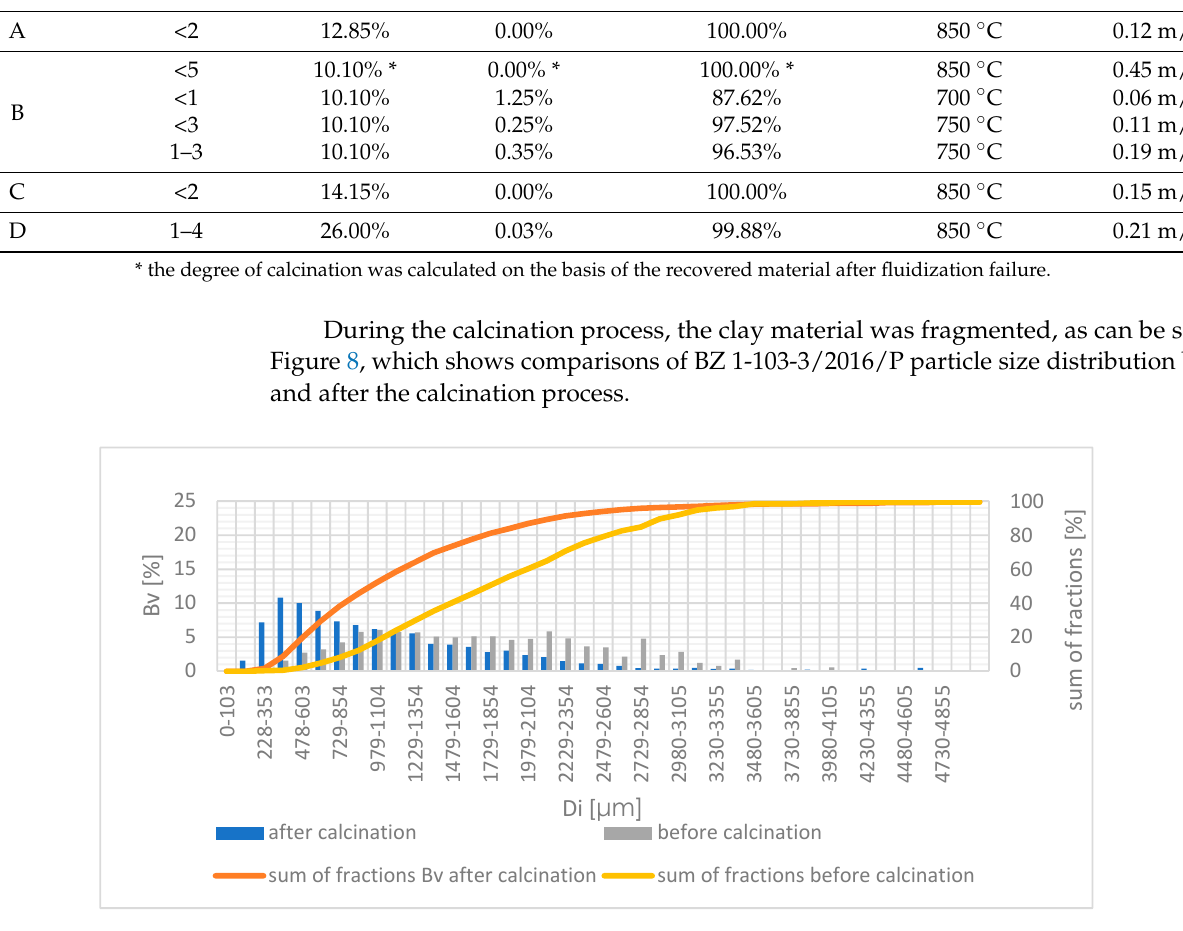
Figure 8. Volume distribution before and after the calcination process for the material D, with a granule size of 1–4 mm.